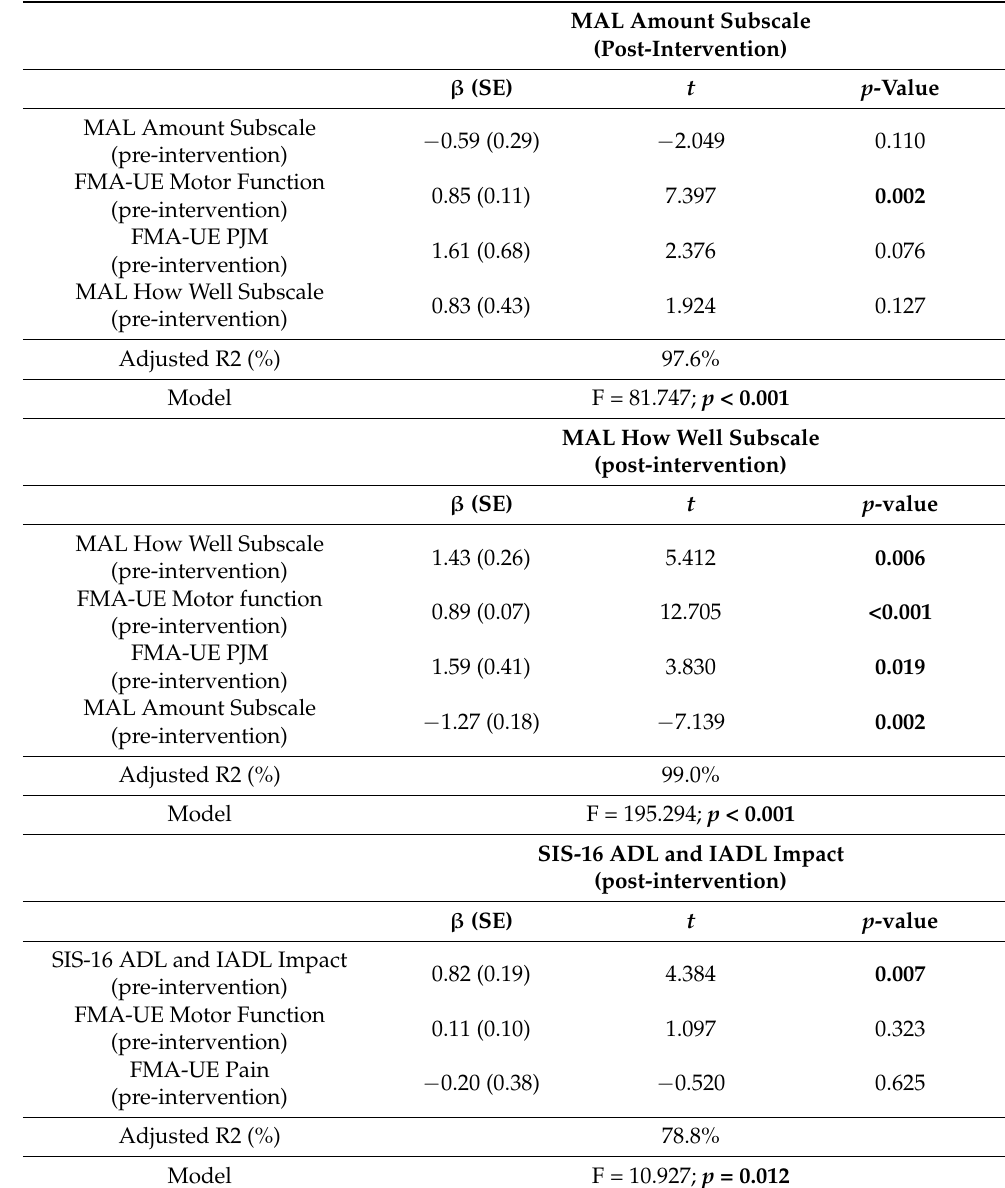
Table 4. Multivariable regression model of the performance measure post-intervention scores in the experimental